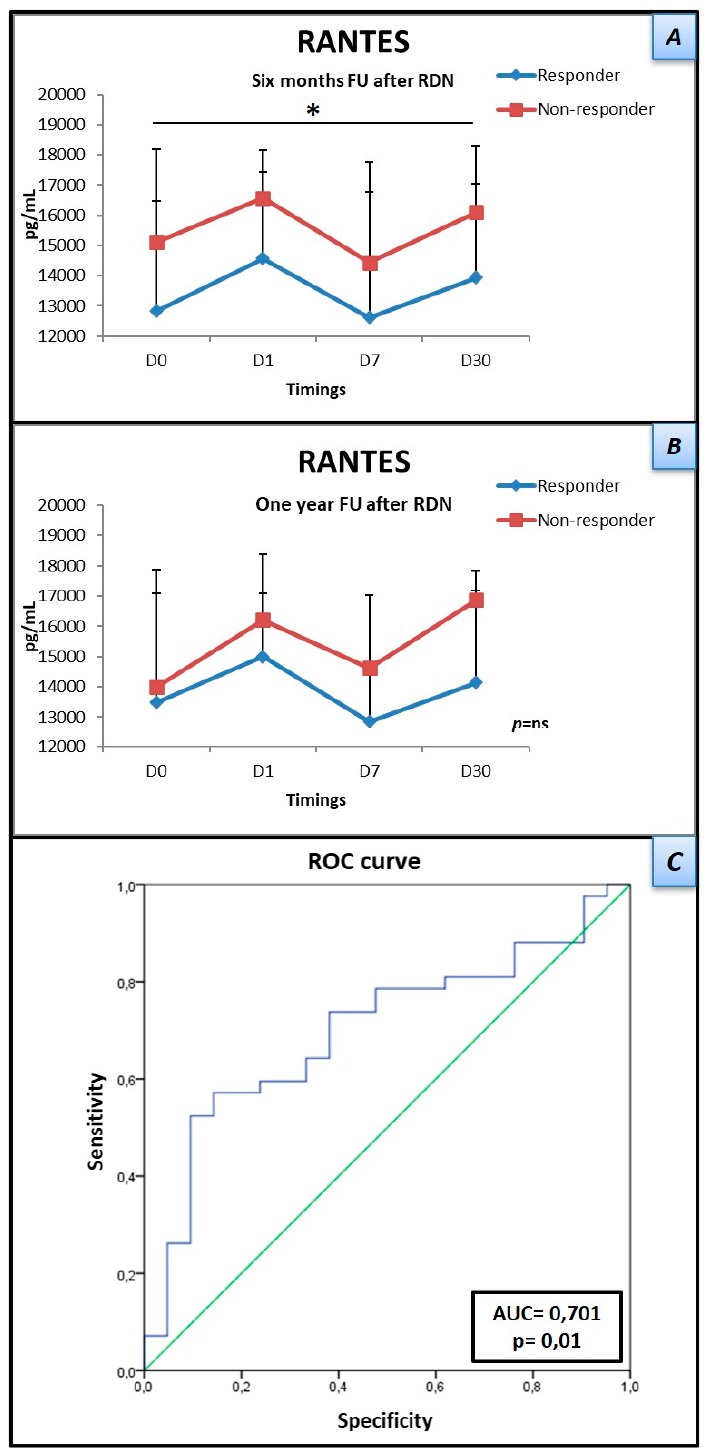
Figure 1. Quantification of RANTES at four time points (D0, D1, D7 and D30—see text), before and after renal denervation. ( A ) Plasmatic levels of RANTES are significantly lower in ‘responders’ (blue line) at six months. ( B ) After one year follow-up, levels of RANTES are still lower, even though statistically non-significant. ( C ) ROC curve: A RANTES cut-off value of ≤ 15,496 pg/mL showed the best overall sensitivity and specificity for determining renal denervation response. Data are presented as mean ± standard deviation. RANTES—regulated upon Activation, Normal T cell Expressed, and Secreted; FU—follow-up; RDN—renal denervation; AUC—area under the curve. * p < 0.05.